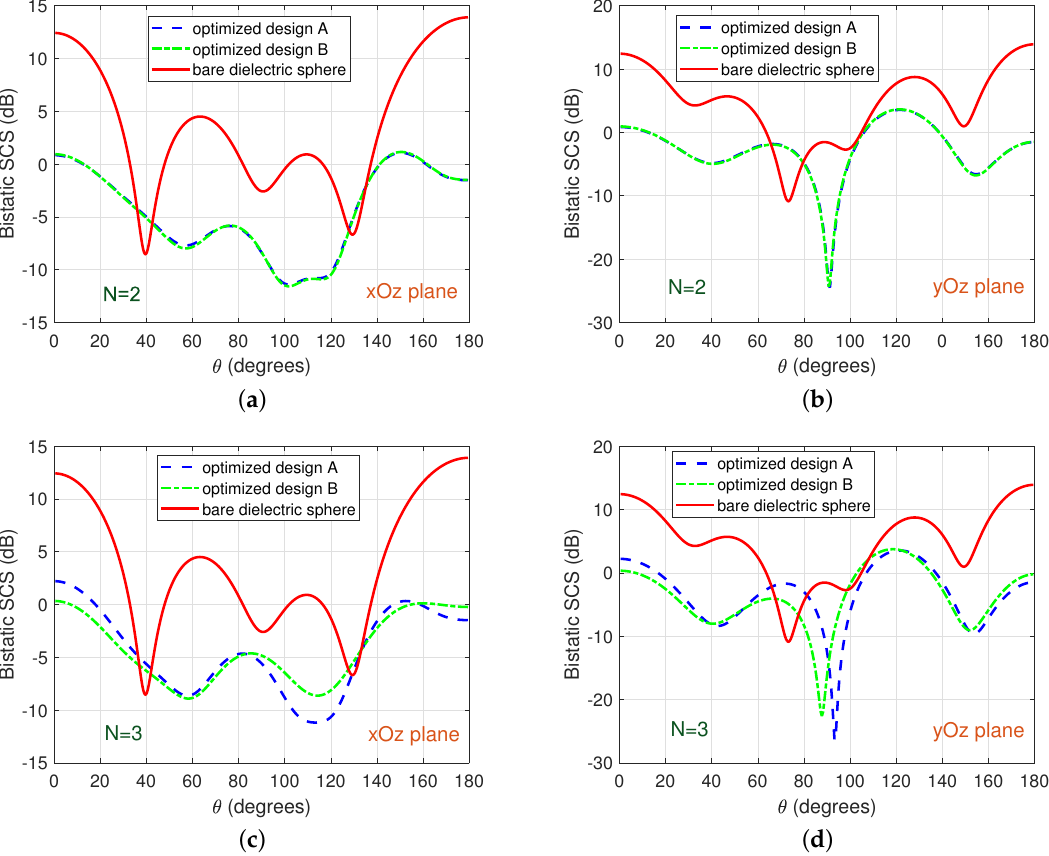
Figure 10. Normalized bistatic SCS σ ( θ , φ ) / ( π a 2 c ) in the xOz and yOz planes versus the angle θ for ( a , b ) N = 2- and ( c , d ) N = 3-optimized spherical layers covering a dielectric core of radius k 0 a c = π and permittivity (cid:101) c = 18.7, excited by a dipole at b = 10 a c . The values of the optimization variables for designs A and B are given in Table A7 of the Appendix